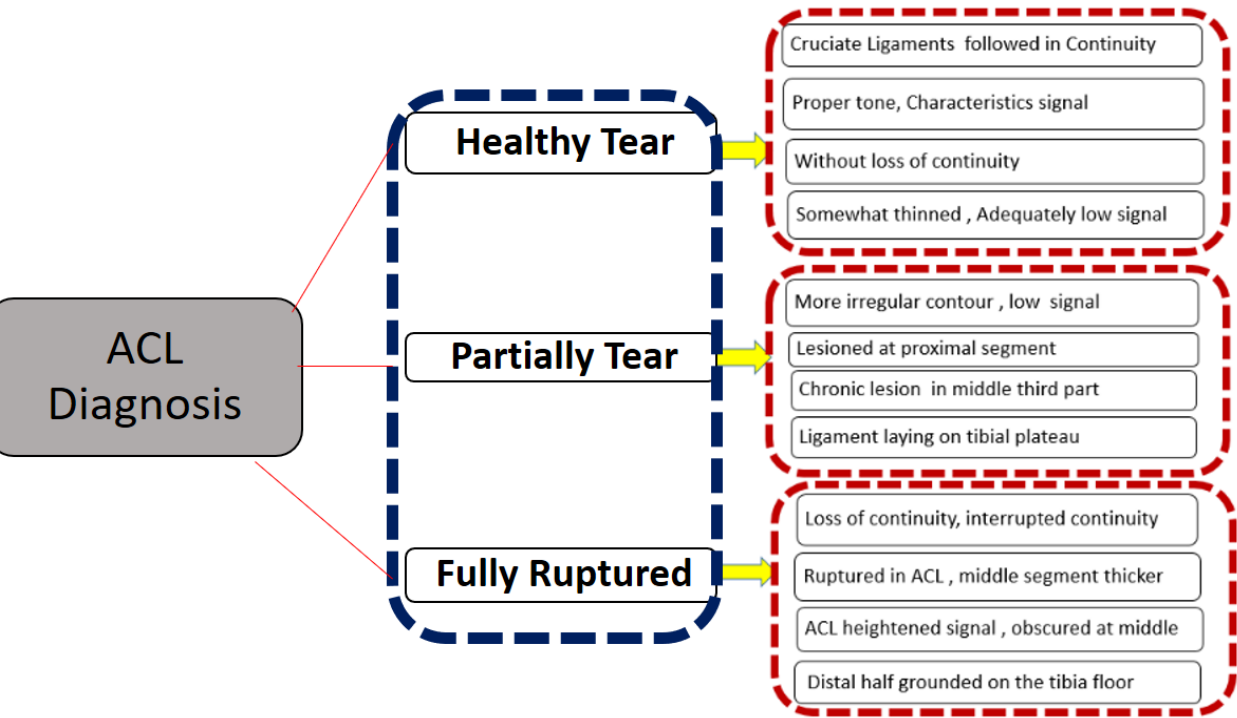
Figure 1. The ACL conditions of the extracted diagnosis criteria.